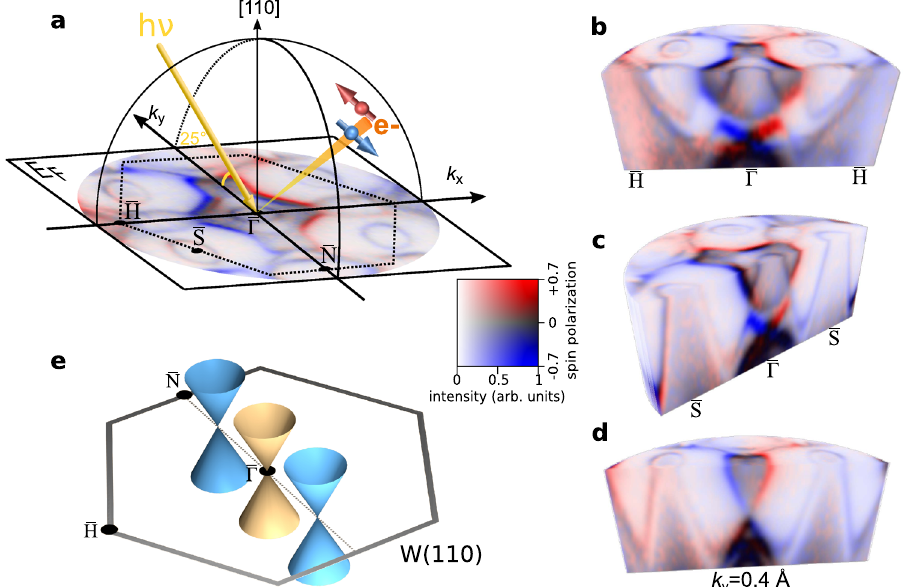
Fig. 1 Multiple d -derived Dirac fermions in the heavy transition metal W(110). a Experimental geometry for spin- and momentum-resolved photoelectron study. The spin-resolved photoemission momentum map at the Fermi energy E F for W(110) is shown. The dashed contour indicates the outline of the surface Brillouin zone of W(110), together with the high-symmetry points ( Γ , H, N, S). b – d Full 3D ( k x , k y , E B ) spin-resolved momentum map with a photon energy of h ν = 50 eV, cutting along H (cid:1) Γ (cid:1) H ( b ), S (cid:1) Γ (cid:1) S ( c ), and k y = 0.4 Å − 1 ( d ) directions of W(110) as a function of binding energies E B ( E − E F from 0 to − 1.7 eV). Measured intensities and spin polarization are encoded using the displayed 2D colour code, where the spin polarization P y is indicated by red and blue colours, and the colour saturation encodes the intensity. e Schematic of the three observed Dirac states for W(110): one appears at the Γ point and two coexist at k y = ±0.4 Å − 1 .